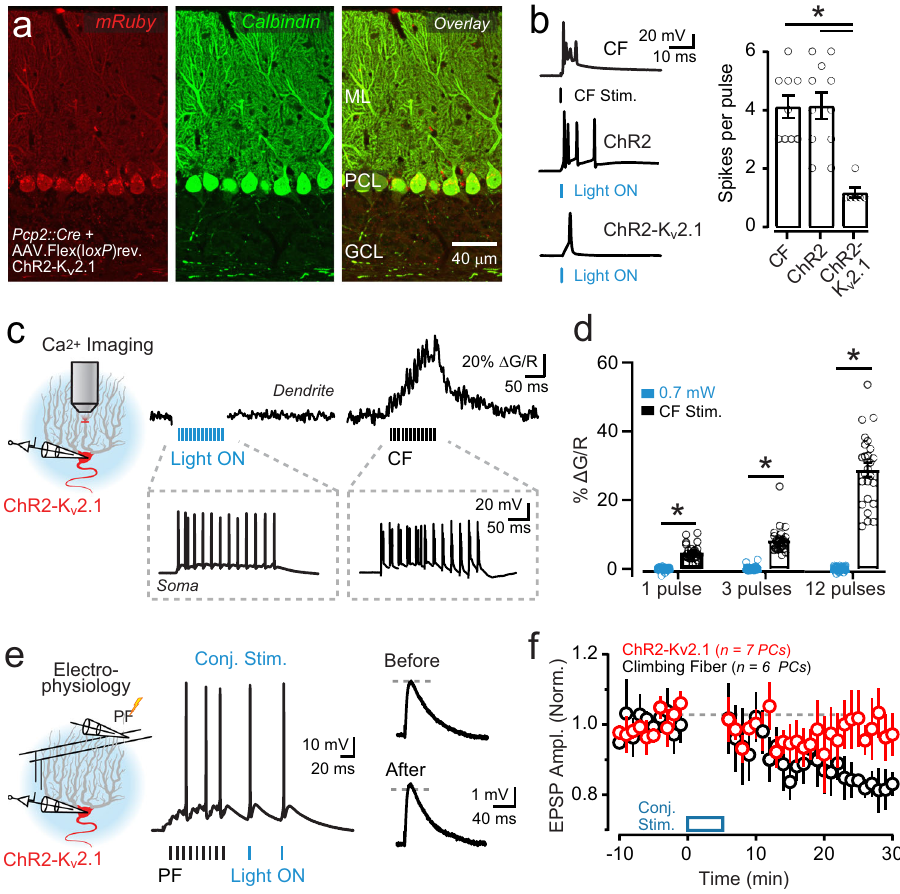
Fig. 5 Absence of optogenetically induced dendritic Ca 2 + signaling and plasticity in PCs with soma-restricted ChR2 expression. a Image from a Pcp2::Cre mouse expressing mRuby-tagged ChR2-K v 2.1 by Cre-dependent AAV transduction; PCs are marked by calbindin immunostaining. b Electrophysiological recordings from the soma of two different PCs, expressing either ChR2 ( n = 11 PCs) or ChR2-K v 2.1 ( n = 6 PCs), in response to single pulses of light (5ms; 0.7 mW/mm 2 ). A complex spike in the ChR2-expressing cell was evoked by climbing- fi ber (CF) stimulation for comparison ( n = 9 PCs). The summary plot on the right shows the average somatic spiking response to the different stimuli (one-way ANOVA with Tukey ’ s post test; CF vs. ChR2: P >0.05, CF vs. ChR2-Kv2.1: P ≤ 0.001, ChR2 vs. ChR2-Kv2.1: P ≤ 0.001). Data from 14 mice. c Dendritic Ca 2 + activity in a ChR2-K v 2.1-expressing PC to a burst of optogenetic stimuli (12 pulses; 5ms; 50Hz; 0.7mW/mm 2 ) or to repeat climbing- fi ber activation. Somatic spiking is shown in the gray boxes below. d Lack of dendritic Ca 2 + signals in response to optogenetic stimuli in PCs expressing ChR2-K v 2.1 ( n = 25 dendrites, four cells, three mice; two-way repeated-measures ANOVA with Dunnett ’